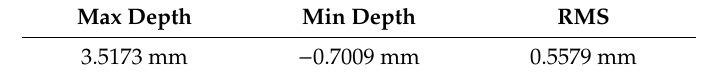
Figure 20. The specific places on the artificial rail surface with scratch-depth larger than 1 mm .